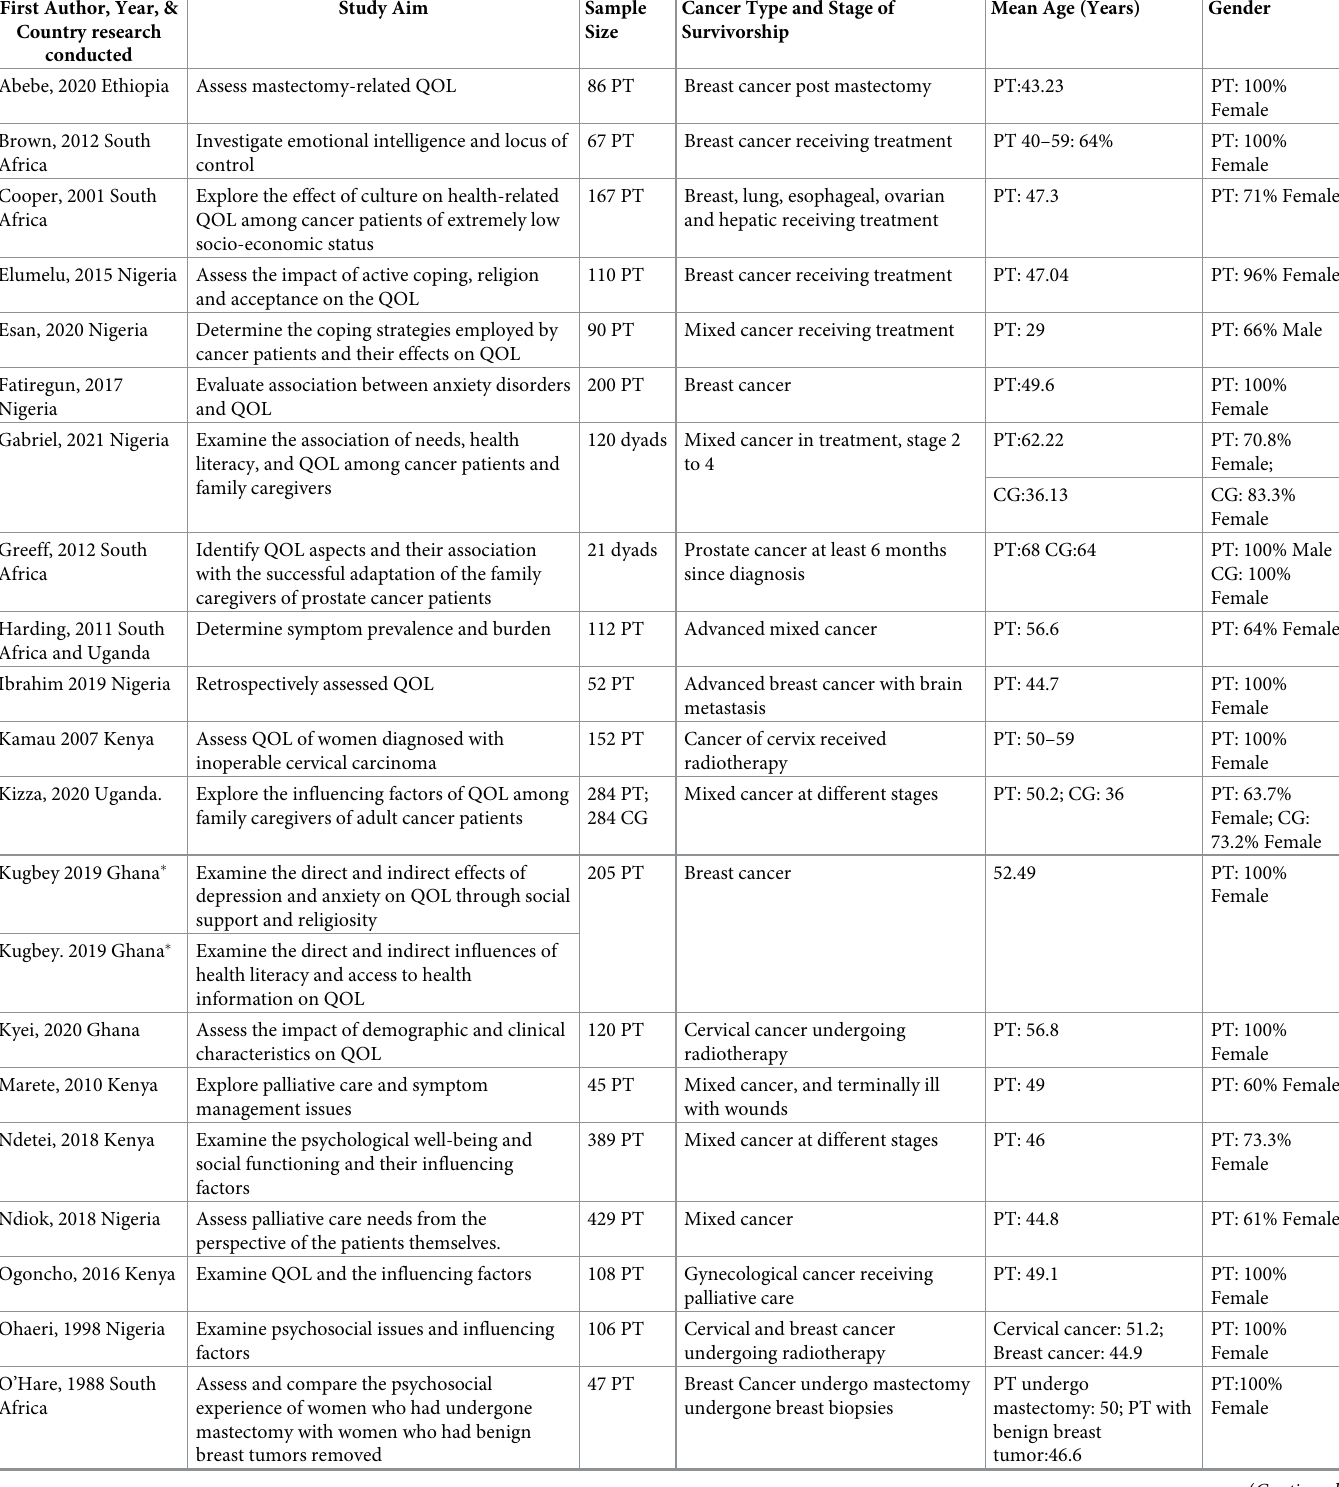
Table 2. Characteristics of study and